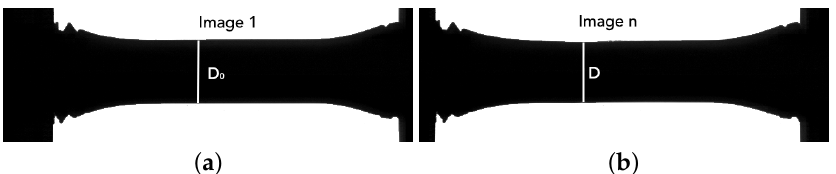
Figure 4. Example of the edge tracing technique used for monitoring the minimum sample diameter during testing. Image 1 ( a ) corresponds to the frame when the test starts and Image n ( b ) corresponds to the frame just before to failure.